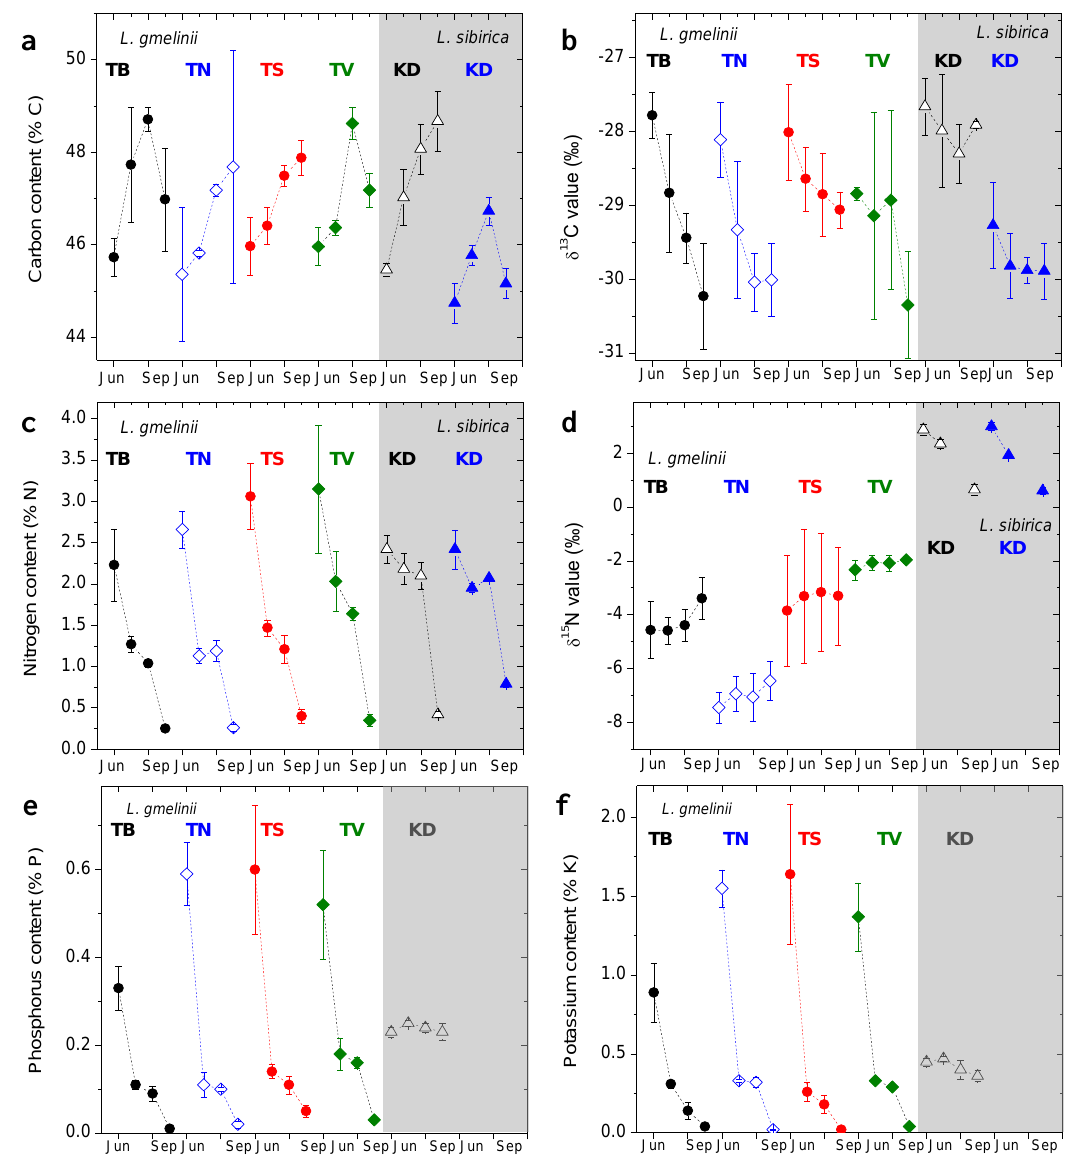
Figure 3. Seasonal dynamics of mean contents of carbon ( a ), carbon stable isotope compositon δ 13 C ( b ), nitrogen ( c ), nitrogen stable isotope composition δ 15 N ( d ), phosphorus content ( e ) and potassium content ( f ) in needles of two larch species (L.g.—Larix gmelinii, L.s. —Larix sibirica) from a permafrost site (Tura: TB—bog; TN—north-facing slope, TS—south-facing slope, TV—riparian zone) and from a permafrost-free site (Krasnoayrsk: KD). Means of tree replicate trees for different dates of sampling based on phenological differences at Tura and Krasnoyarsk.